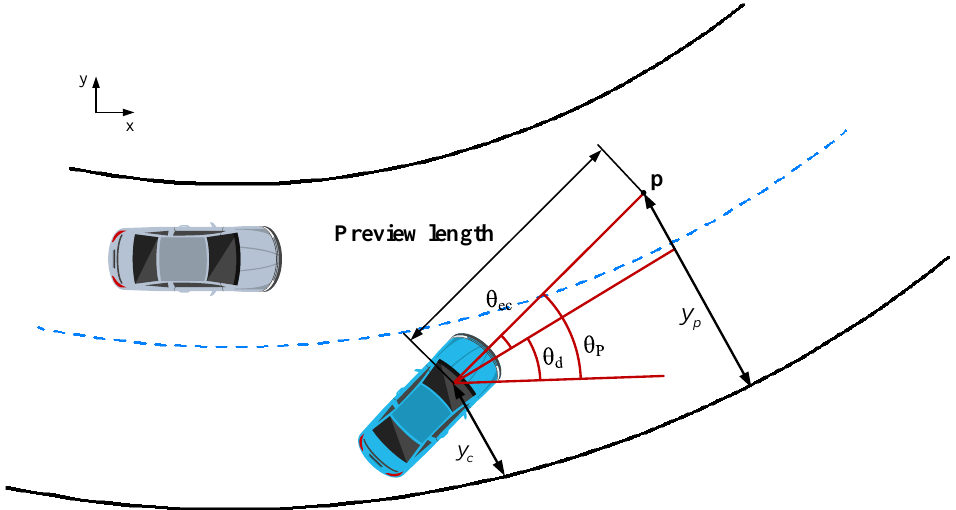
Figure 7. Driver preview model.